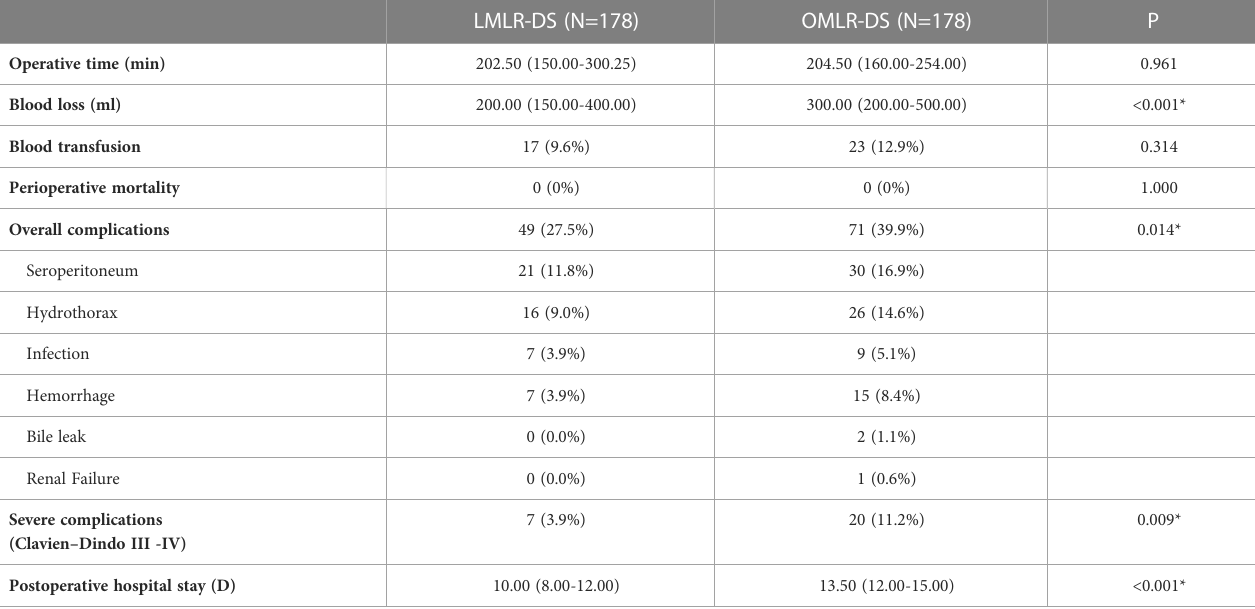
TABLE 3 Operative details and postoperative outcomes between laparoscopic minor liver resection in dif fi cult segments (LMLR-DS) and open minor liver resection in dif fi cult segments (OMLR-DS) groups after propensity score matching.